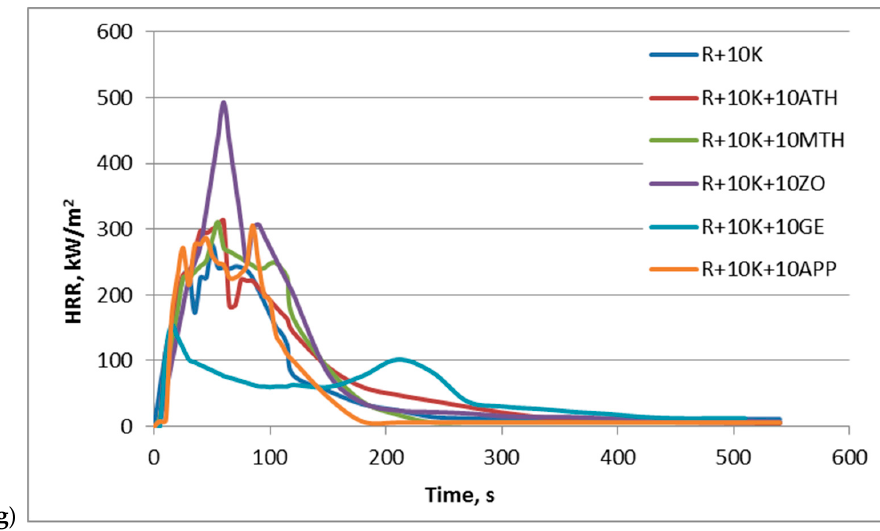
cFigure 7. Summary of heat release rate as a function of time for SRPUF samples:.( a ) R; R+10K; Figure 7. Summary of heat release rate as a function of time for SRPUF samples: ( a )